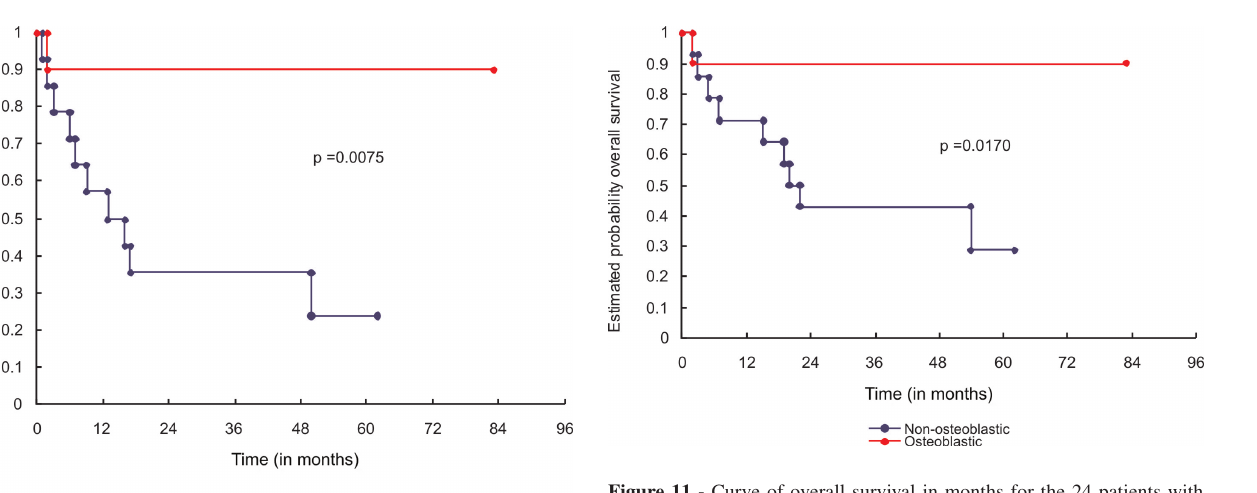
Figure 11 - Curve of overall survival in months for the 24 patients with primary osteosarcoma that was non-metastatic at diagnosis, according to histological type